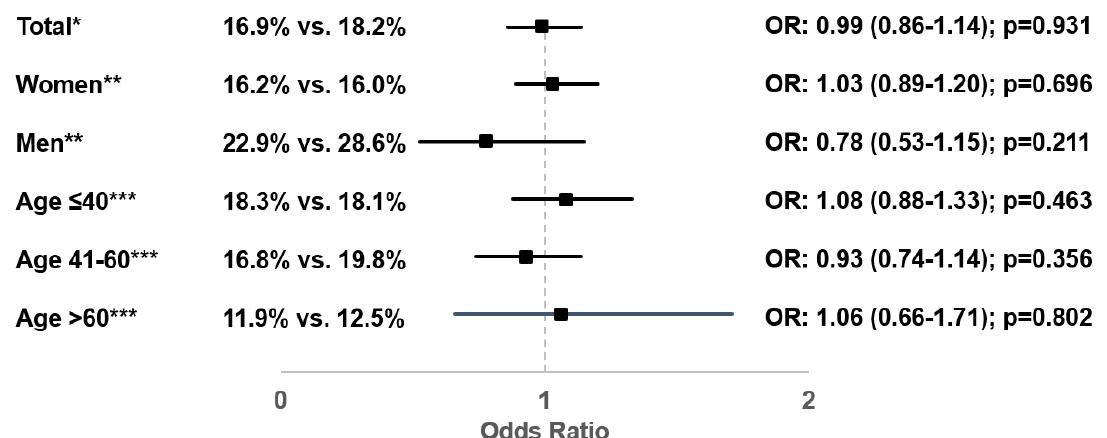
Figure 4. Association between Canephron ® prescription and probability of sick leave of at least 3 days (Canephron ® versus antibiotic). * Multivariable logistic regression adjusted for age, sex, health insurance coverage, practice specialty, and CCI. ** Multivariable logistic regression adjusted for age, health insurance coverage, practice specialty, and CCI. *** Multivariable logistic regression adjusted for sex, health insurance coverage, practice specialty, and CCI.